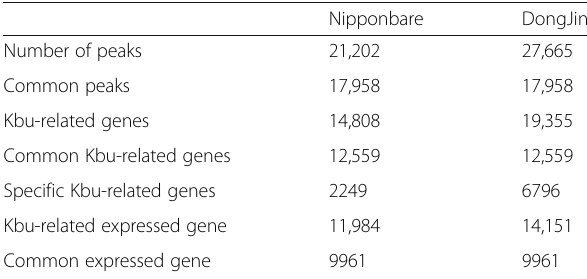
Table 3 Summary of Kbu-related genes and peaks of two rice varieties (Nipponbare and DongJin)